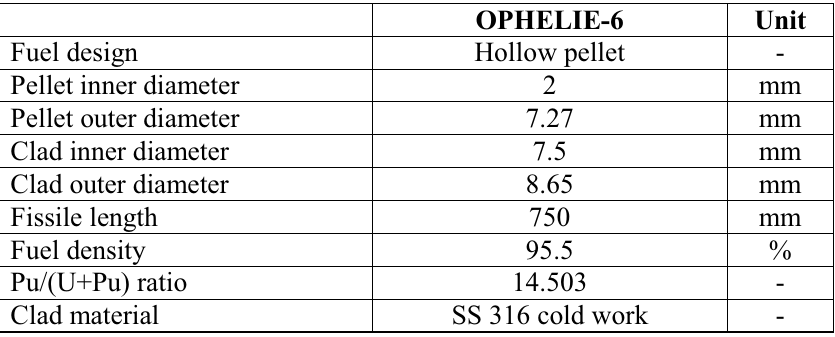
Table I. OPHELIE-6 design